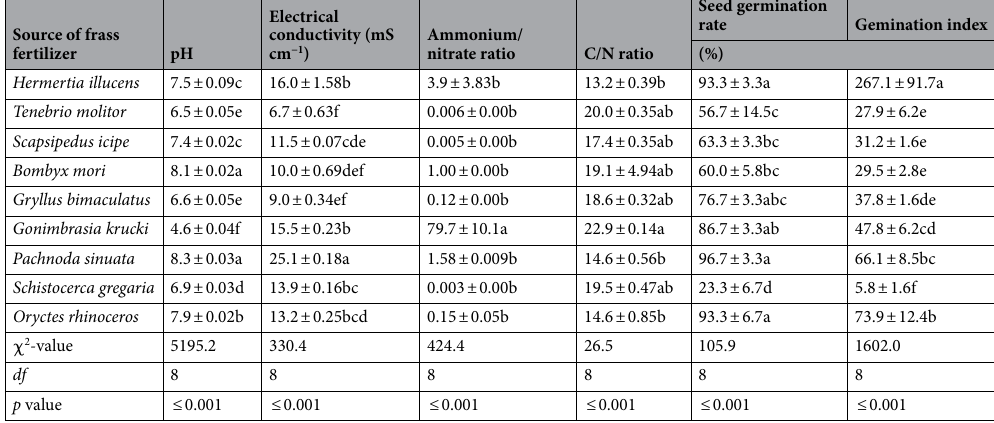
Table 4. Compost maturity indices of frass fertilizer produced by different edible insect species. C/N ratio = ratio of total organic carbon to total nitrogen. In the same column, means (± standard error) followed by the same letters are not significantly different at p ≤ 0.05, n =